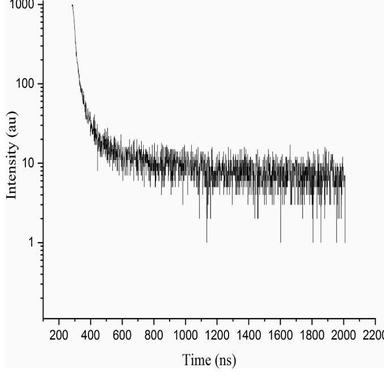
DECAY CURVE